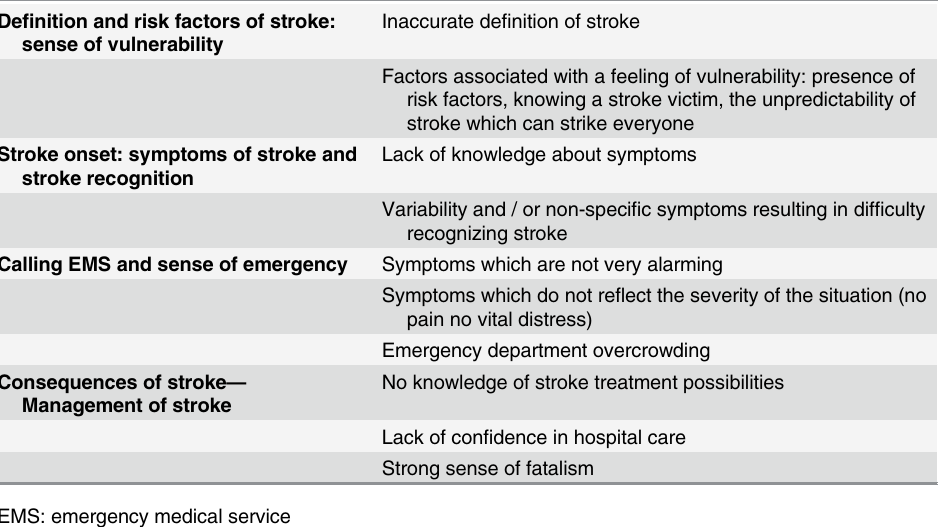
Table 3. Summary of the main results based on each theme discussed. De fi nition and risk factors of stroke: sense of